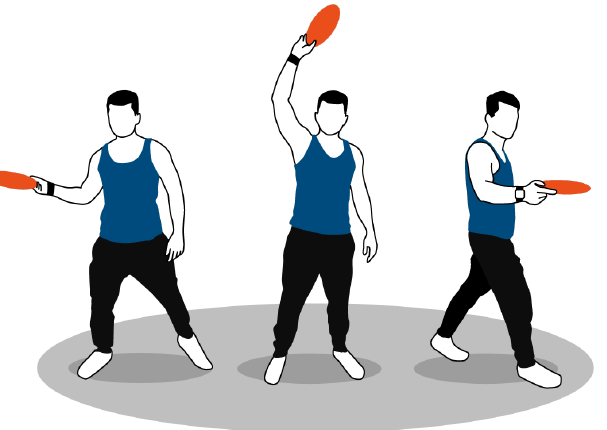
Figure 2. The three main throwing techniques in Ultimate Frisbee are, from left to right, forehand, overhead and backhand. The sensor is placed at the wrist of the dominant hand. The sensor (white) is fixed with a wristband